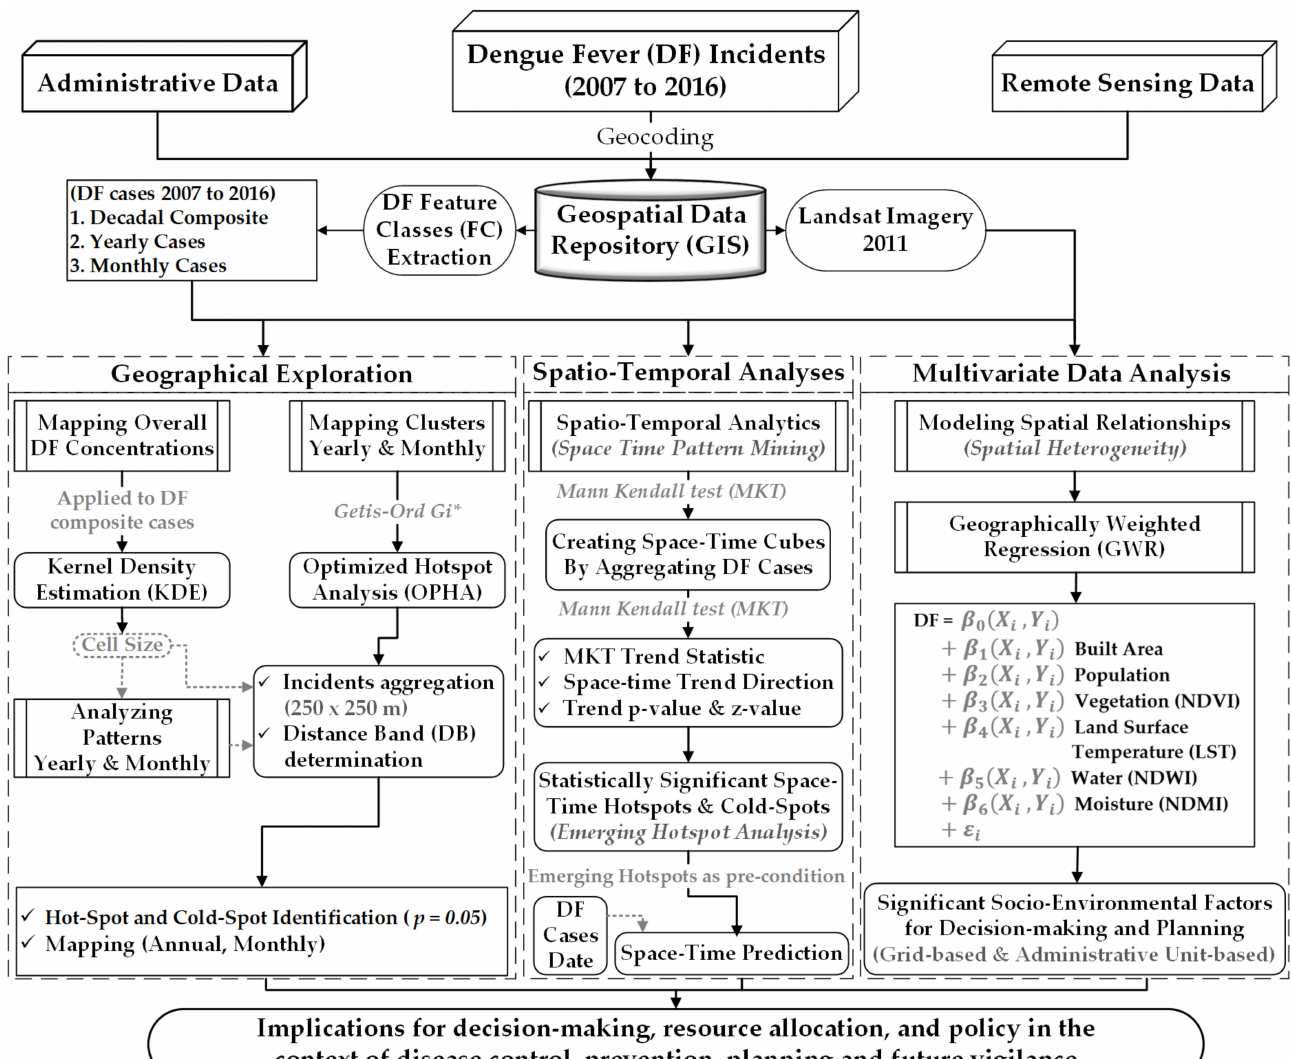
Figure 1. Methodological framework (I-SpaDE